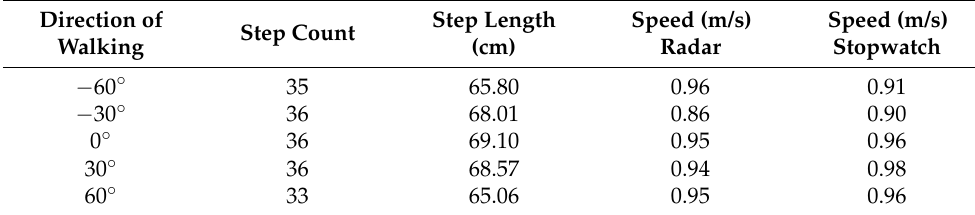
Table 4. Extracted gait values in a clutter-free at various angles. Direction of